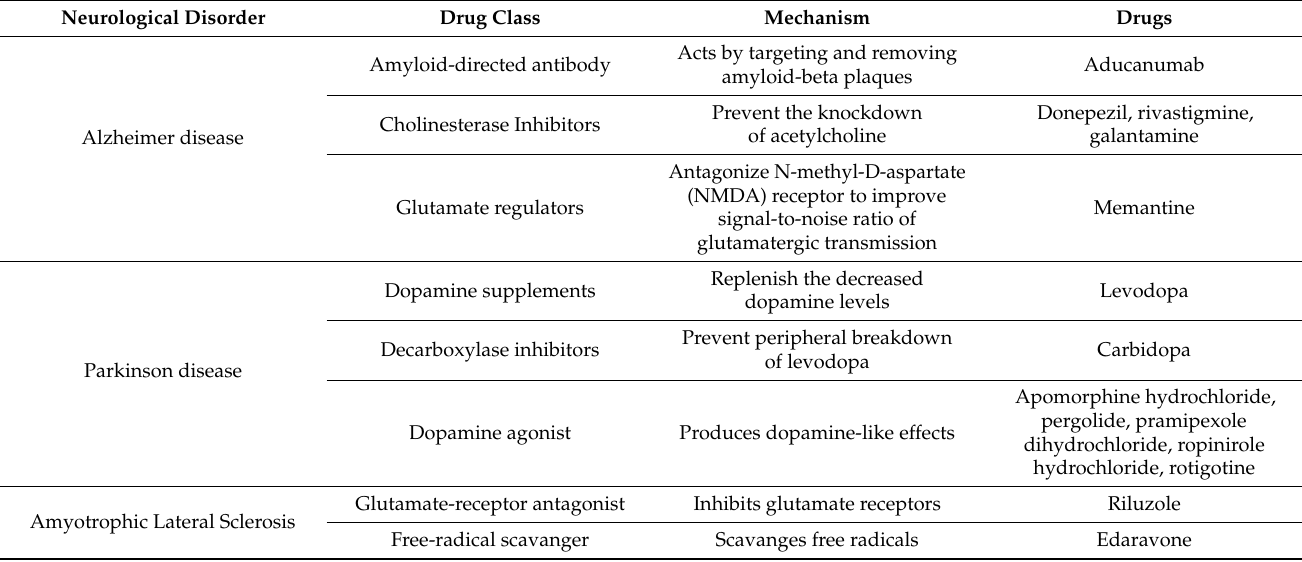
Table 1. Current therapeutic approaches for the management of neurodegenerative